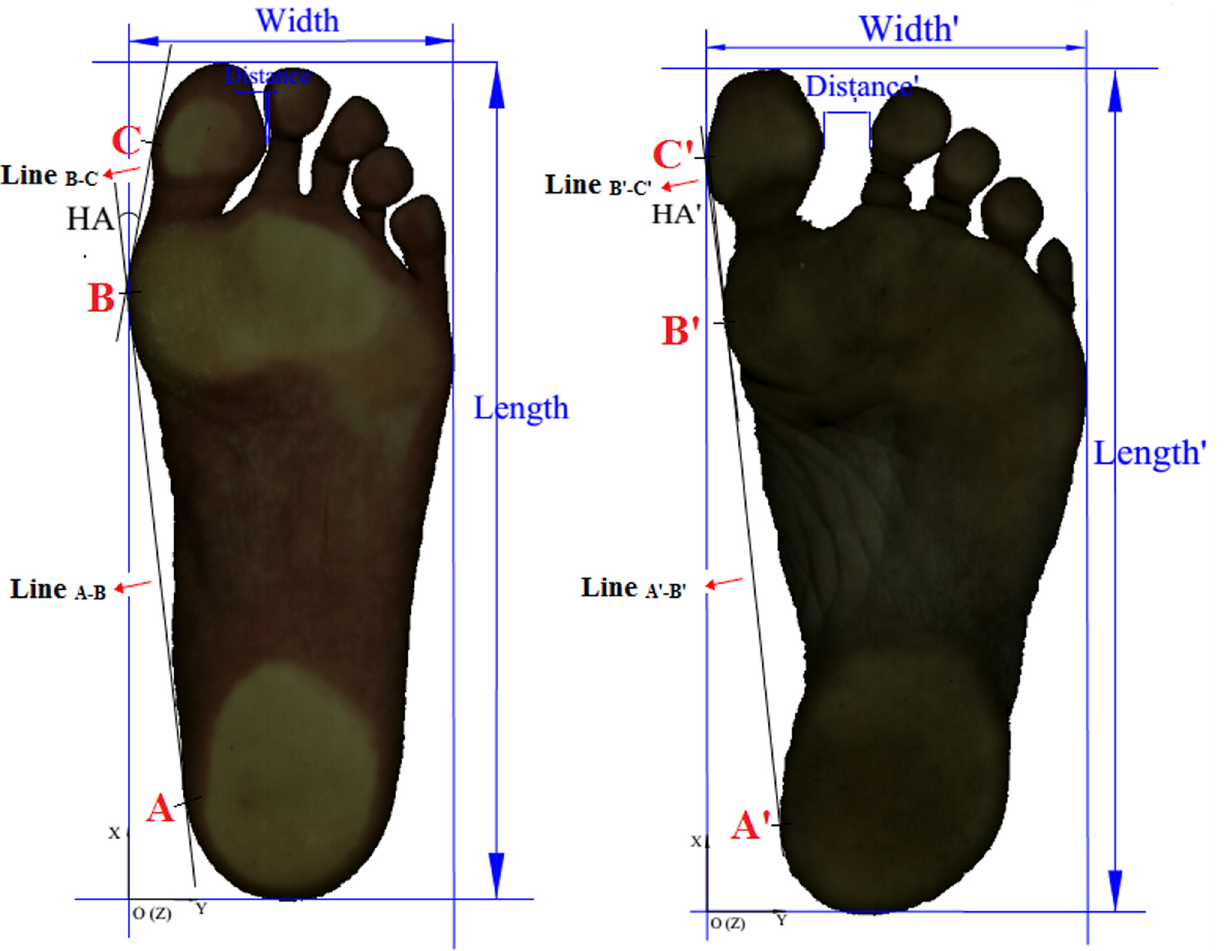
Fig 1. 2D foot print image of habitually shod (left) and unshod (right)